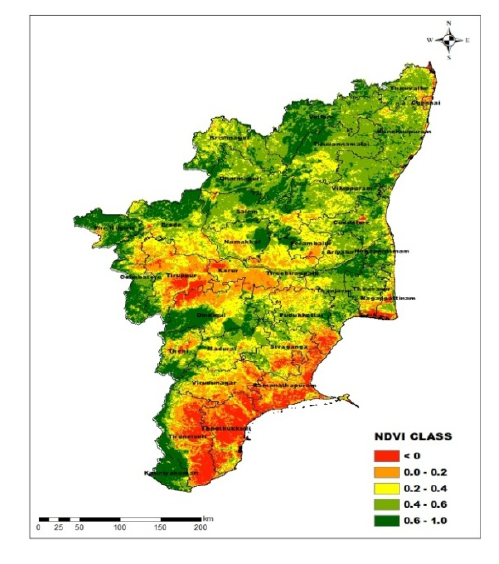
Fig. 1. Zonal Averaged NDVI Classes During Kharif Season of 2017 in Tamil Nadu